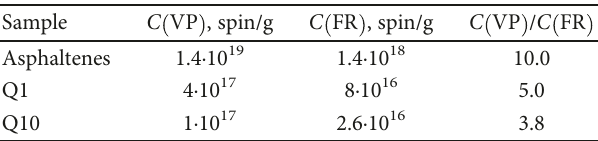
Table 3: Concentrations (C) о f FR and VP in asphaltenes and the adsorbed samples from the X-band